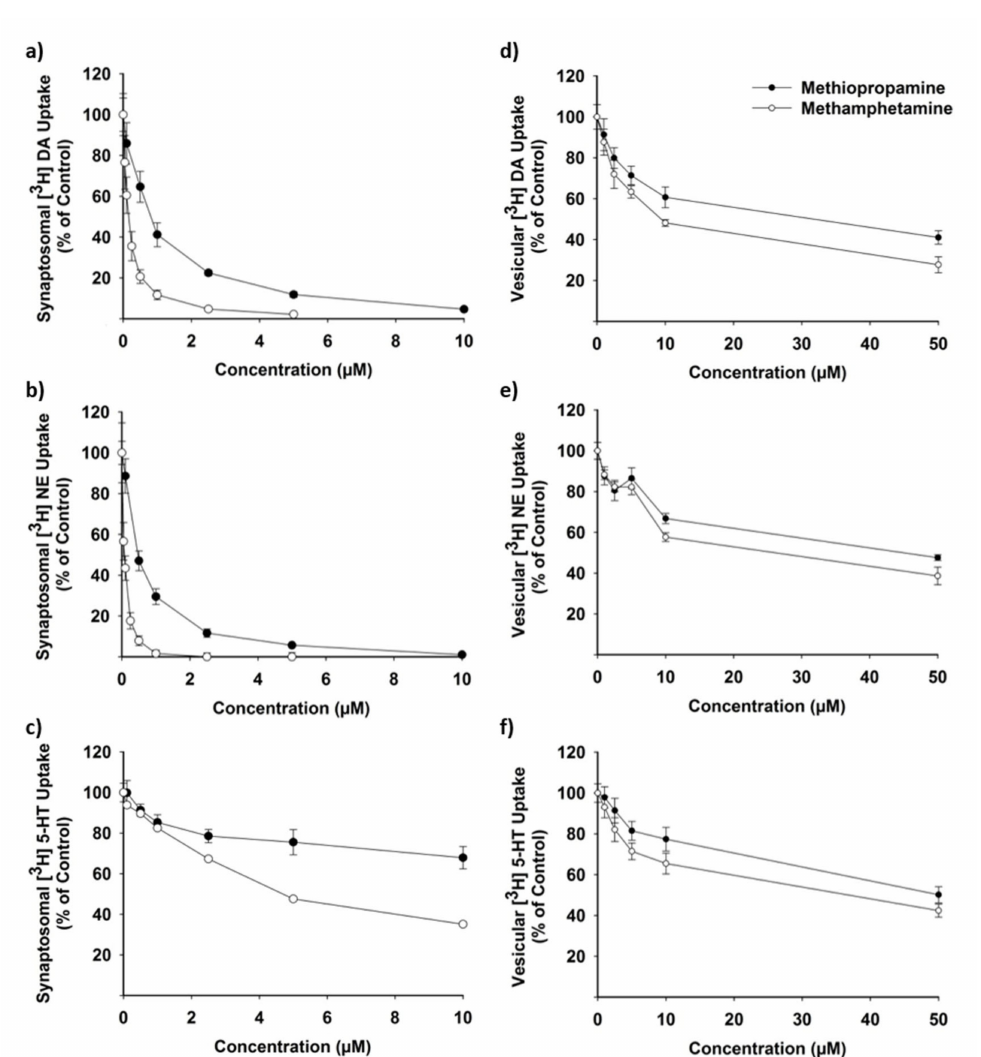
Figure 4. Effects of methiopropamine (0.1–50 µ M) and methamphetamine (0.05–50 µ M) on ( a – c ) synaptosomal and ( d – f ) vesicular uptake of [ 3 H] dopamine (DA), [ 3 H] norepinephrine (NE) and [ 3 H] serotonin (5-HT) in rat brain synaptosomes and synaptic vesicles in vitro, n =